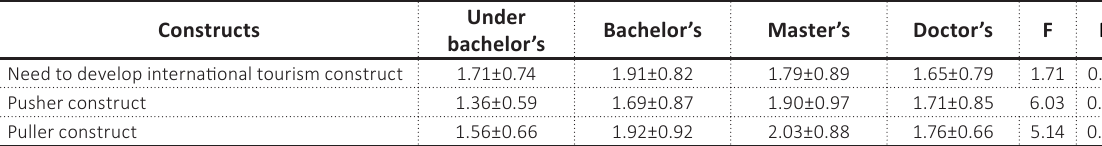
Table 12. Education level difference analysis Constructs